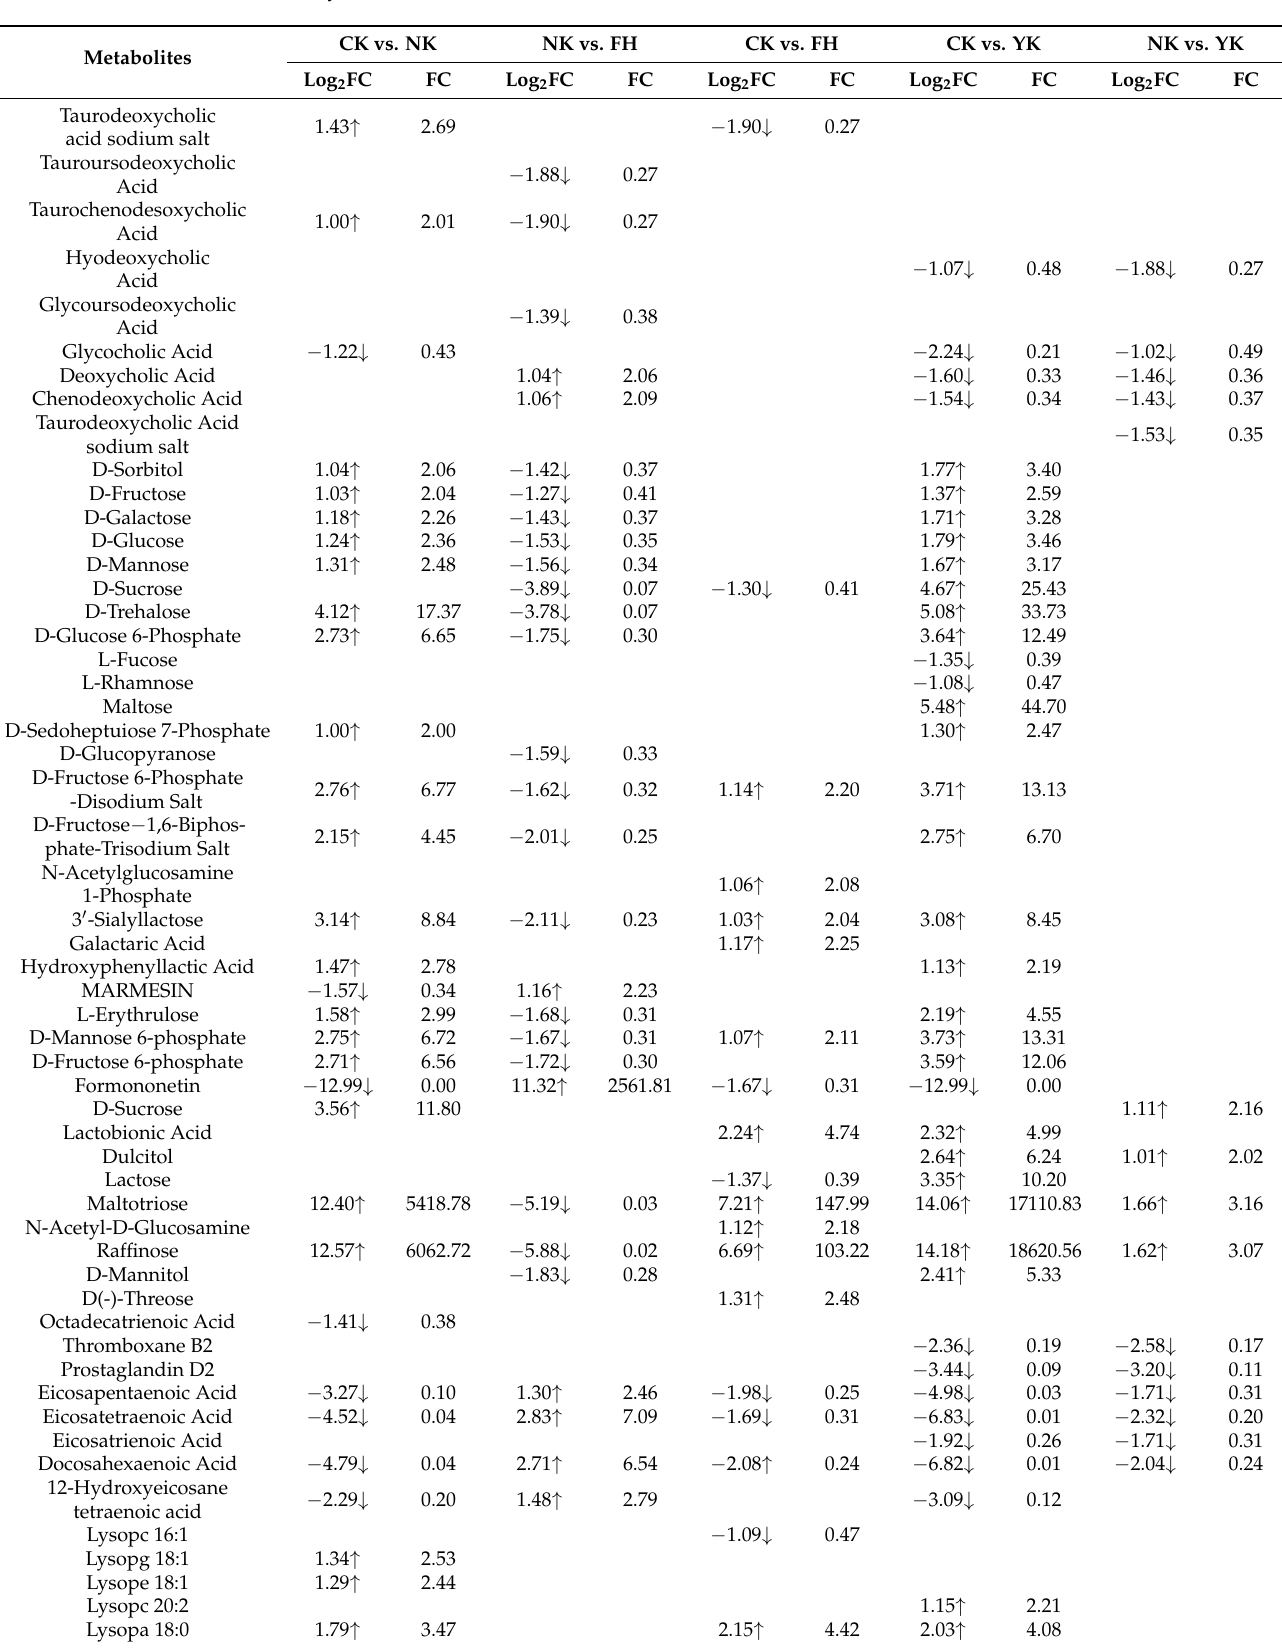
Table 2. Significant changes in potential metabolites were identified by LC—MS in mice liver induced by